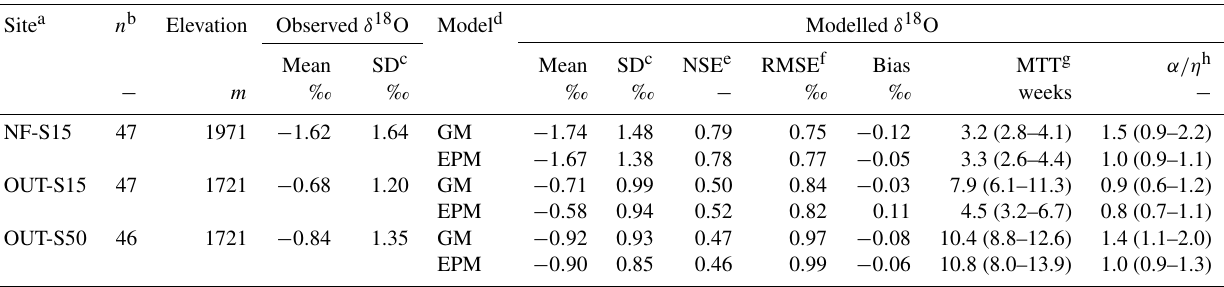
Table 6. Main statistical parameters of observed and modelled δ 18 O for mobile soil water at 15cm depth in the natural forest sub-catchment and at 15 and 50cm depth in the main catchment for the gamma model (GM) and exponential piston flow model (EPM). Uncertainty bounds of the modelled parameters ( τ and α or η ), in parentheses, were calculated through generalized likelihood uncertainty estimation